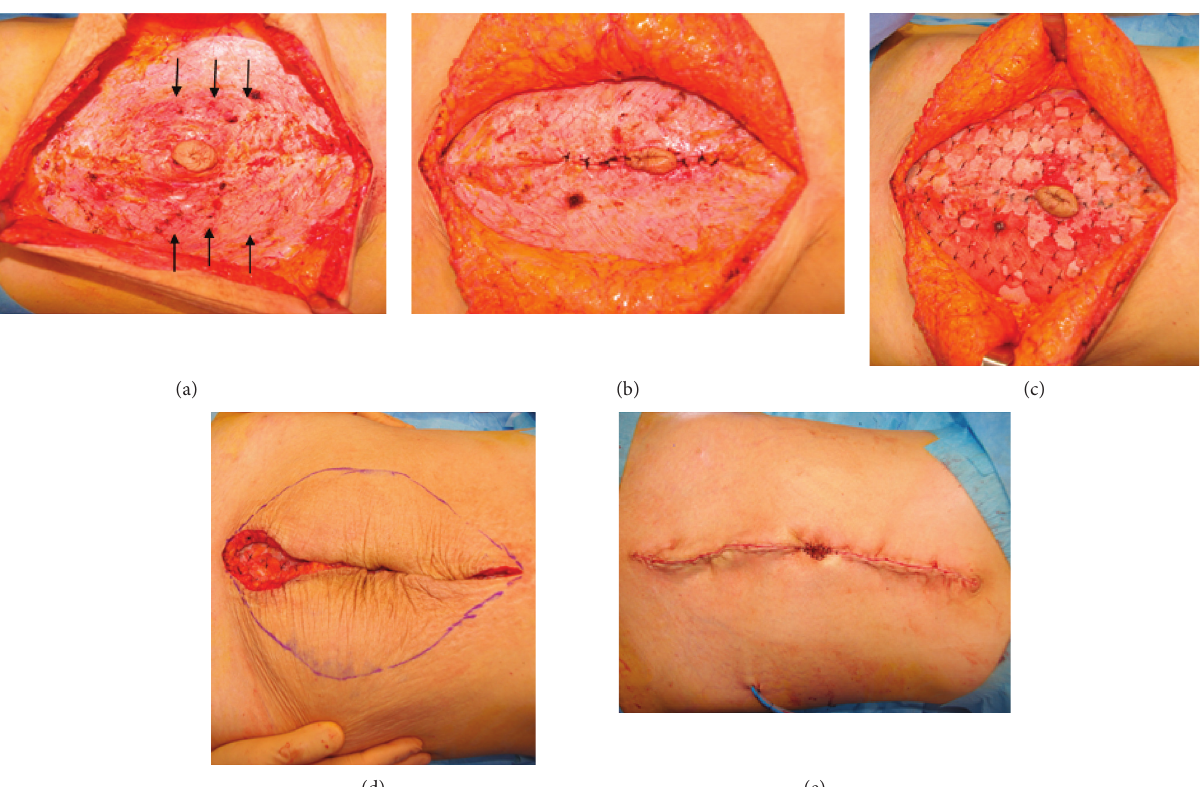
Figure 3: Intraoperative photographs. (a) The rectus abdominis muscle is displaced to the left and right. The peritoneum is intact. (b) The anterior rectus muscle is sutured. (c) A mesh is applied to the rectus abdominal muscle. (d) Excess skin is removed in a spindle shape. (e) Closure of the incision.